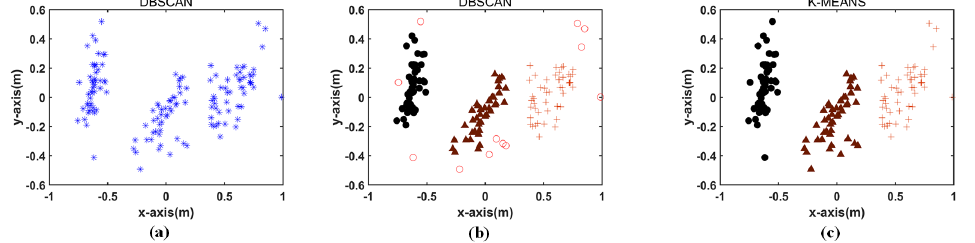
Figure 20. DBSCAN-based noise removal simulation. ( a ) The raw data of point cloud. ( b ) The performance of the DBSCAN algorithm. ( c ) The performance of the K-MEANS